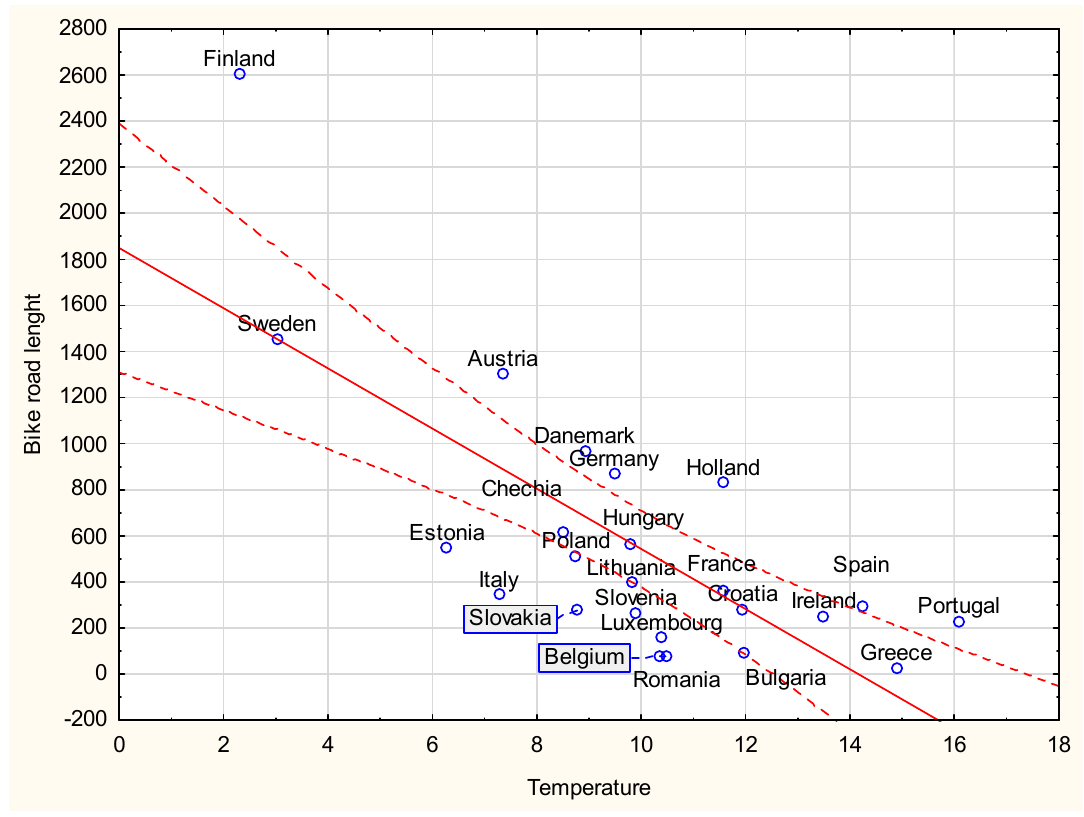
Figure 5. Scatter plot between the country’s average temperature and the average length of bicycle routes in the smart cities. Source: author’s analysis.